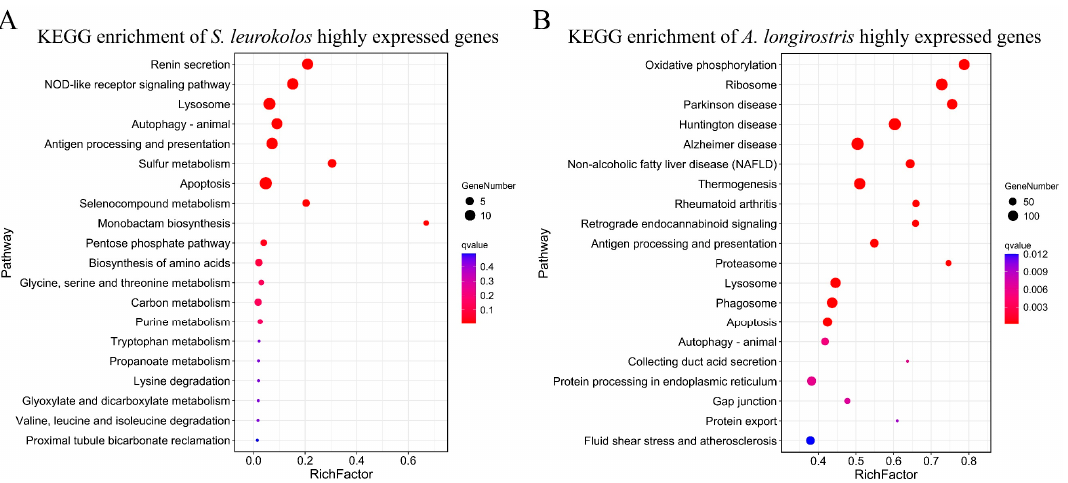
Figure 2. The 20 most enriched KEGG pathways of highly expressed genes in ( A ) S. leurokolos and ( B ) A. longirostris . “Rich factor” refers to the ratio of the highly expressed gene number and the number of genes involved in this pathway (the greater the Rich factor, the greater the degree of enrichment).The dot size is proportional to the number of enriched genes in the pathway. Red color intensity increases with enrichment